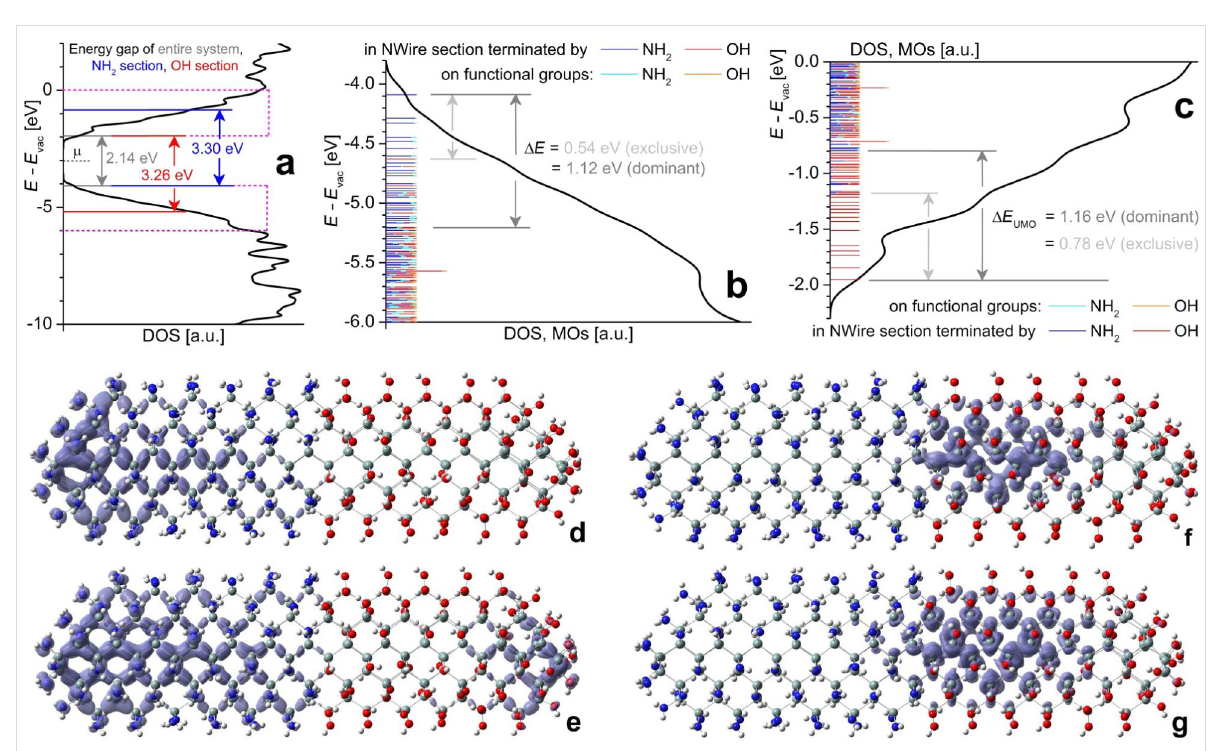
Figure 6: Electronic properties obtained by h-DFT for Si 233 (NH 2 ) 87 (OH) 81 NWire of 1.4 nm diameter and 5.2 nm length, terminated with NH 2 on its left half emulating Si 3 N 4 -embedding and with OH on its right half emulating SiO 2 -embedding: (a) DOS over energy relative to vacuum level E vac . Red (blue) lines show HOMO–LUMO-gap of OH-terminated (NH 2 -terminated) NWire section. Global HOMO–LUMO gap shown in grey together with Fermi energy E F for entire NWire. Magenta DOS sections are enlarged to show MO locations for (b) frontier-OMOs and (c) frontier-UMOs along with Δ E for exclusive and dominant MO location in the respective NWire section. (d–g) Si 233 (NH 2 ) 87 (OH) 81 approximant after structural optimization; for atom colours see Figure 1. The approximant is shown with the sum of frontier-MO densities ρ MO = as iso-density plots for: (d) frontier- OMOs exclusively located in the NH 2 -terminated NWire section ( ρ MO = 1 × 10 − 3 states/ a 03 = 6.76 states/nm 3 ), (e) frontier-OMOs dominantly located in the NH 2 -terminated NWire section ( ρ MO = 3 × 10 − 3 states/ a 03 = 20.3 states/nm 3 ). A slight distortion of atomic positions occurs at the OH-termi- nated end due to electrostatic forces, leading to a minor location of MOs otherwise exclusively residing in the NH 2 -terminated NWire section. This effect does not occur at NWire devices where SiO 2 coverage is followed by a contact layer, see Figure 7. (f) Frontier-UMOs exclusively located in the OH-terminated NWire section ( ρ MO = 2 × 10 − 3 states/ a 03 = 13.5 states/nm 3 ), and (g) frontier-UMOs dominantly located in the OH-terminated NWire section ( ρ MO = 3 × 10 − 3 states/ a 03 = 20.3 states/nm 3 ). Values for ρ MO are scaled to provide ρ MO = 1 × 10 − 4 states/ a 03 = 0.675 states/nm 3 per